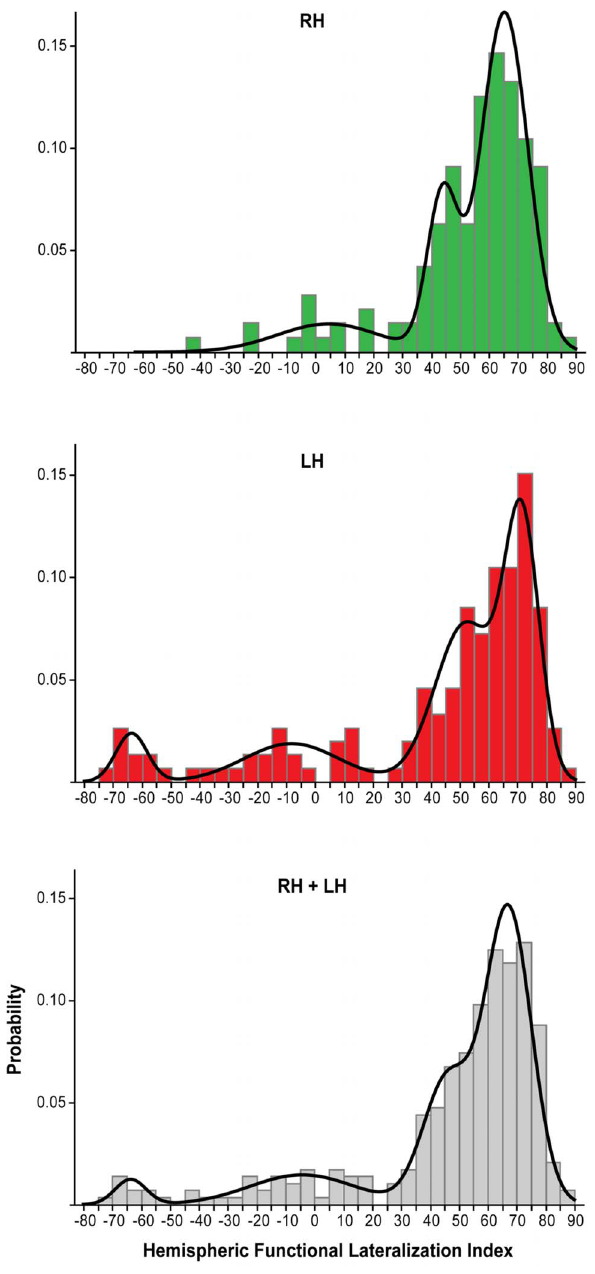
Figure 4. Histogram distribution of hemispheric functional lateralization index (HFLI) in right-handers (RH, top panel), left-handers (LH, middle panel) and whole sample (RH + LH, bottom panel). Solid lines are fits of these distributions by models of mixture of n Gaussian distributions (n=3 for RH, n=4 for LH and whole